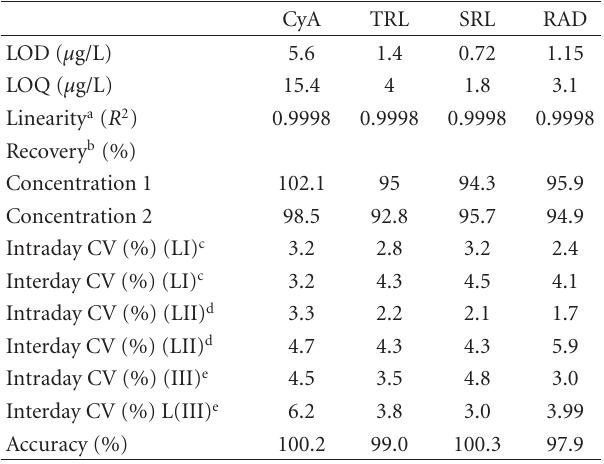
Table 3: Method performance